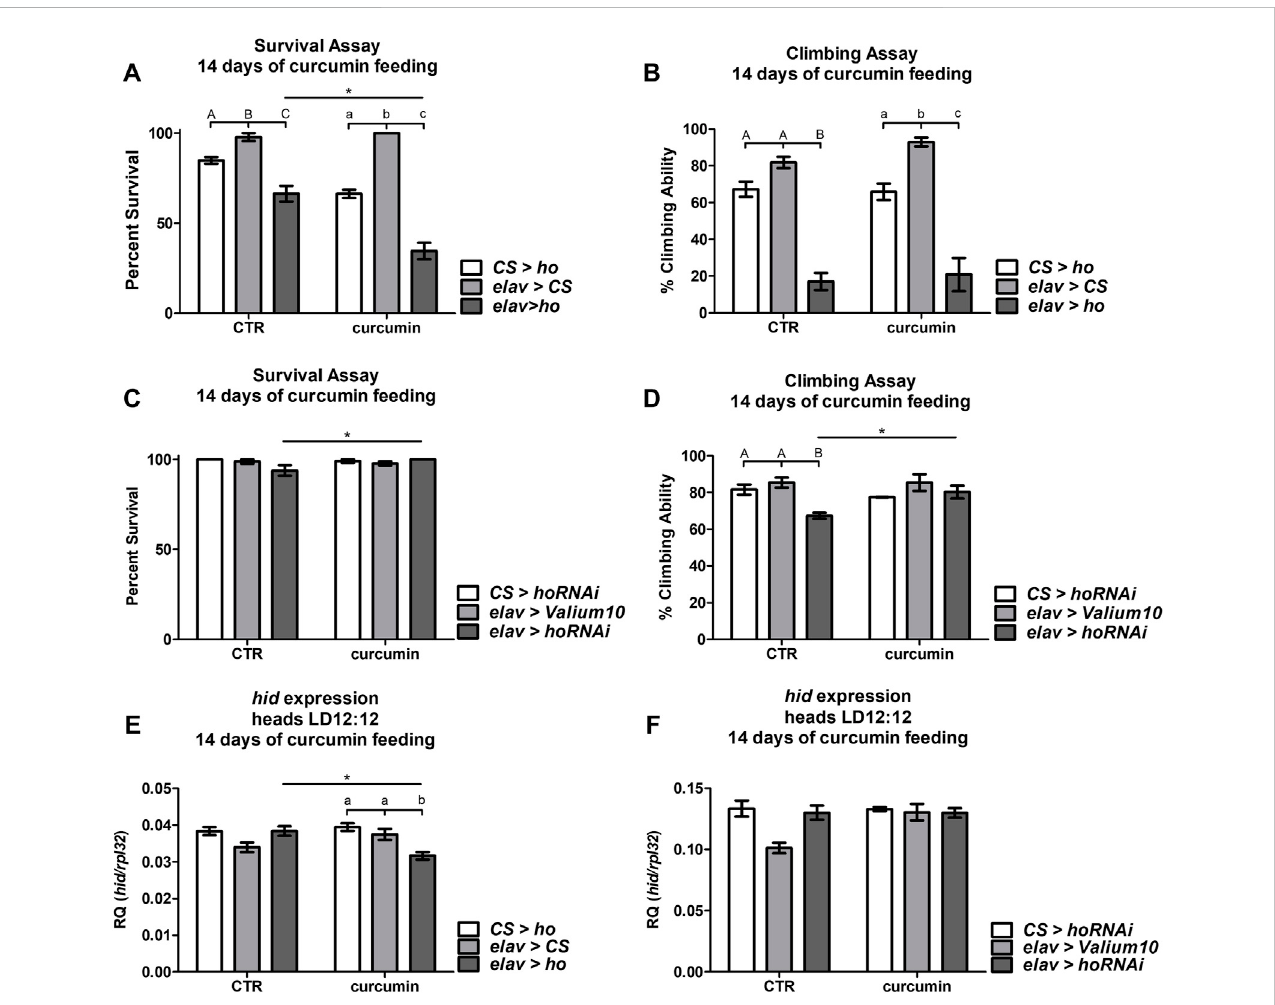
FIGURE 7 Chronic curcumin supplementation changed the survival, climbing ability, and expression of cell death activator gene hid in fl ies with overexpressed (A,B) , and (E) or silenced (C,D) , and (F) ho in all neurons. Statistically signi fi cant differences between genotypes per treatment are indicated with different letters ( capital letters for control and small letters for groups supplemented with curcumin; non-parametric ANOVA Kruskal – Wallis and post hoc Conover- Iman tests)and between treated ornon-treated fl ieswith curcumin ineachgenotypeby asterisks (non-parametricMann Whitney test).Exact p values of percentage (%) of survival and climbing ability, including hid expression, of the different combinations between genotypes and treated or non-treated groups are listed in Supplementary Table